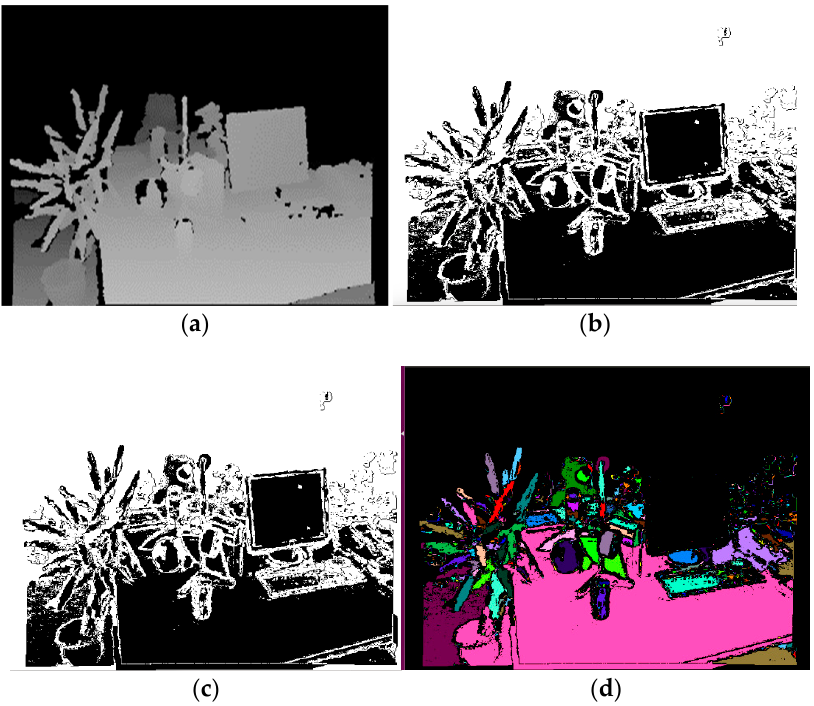
Figure 4. Each stage processing results of geometric segmentation on current frame depth data ( a ) Depth data processed by bilateral filtering; ( b ) raw geometric segmentation results; ( c ) dilation and erode segmentation results; ( d ) final statistical results of geometric components (each color represents a component), showing that the potted plant is over-segmented in multiple components.